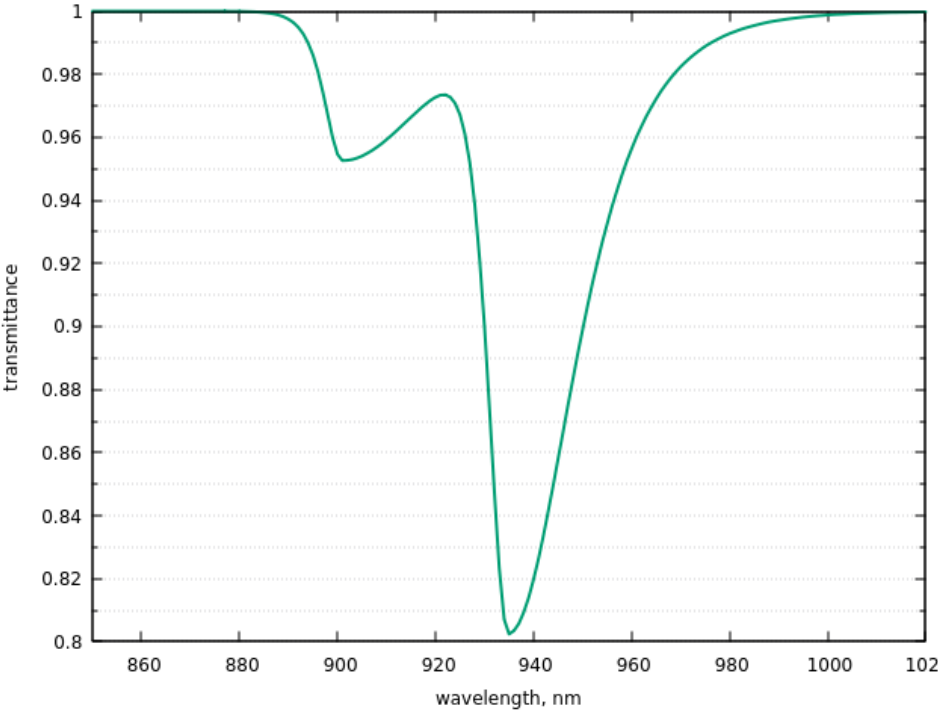
Figure 4. Water vapor transmittance at N H 2 O = 0.33 mm=, t = 233 K, P = 325 hPa, m H 2 O =